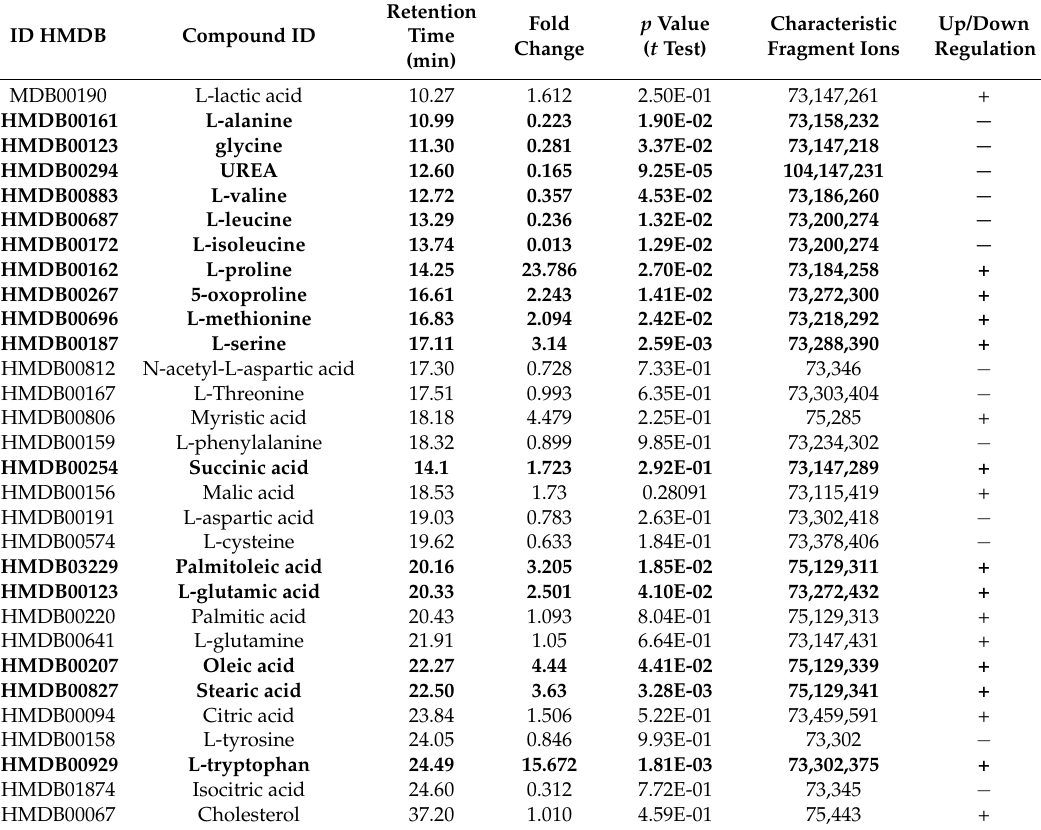
Table 1. Metabolite compounds that were deregulated in gp120-treated U87 glioma cells compared to untreated cells according to GCMS/MS metabolomics analysis. * Cells were treated with gp120 for 10 days. Compounds highlighted in bold have values that are significantly different from the untreated group ( p <